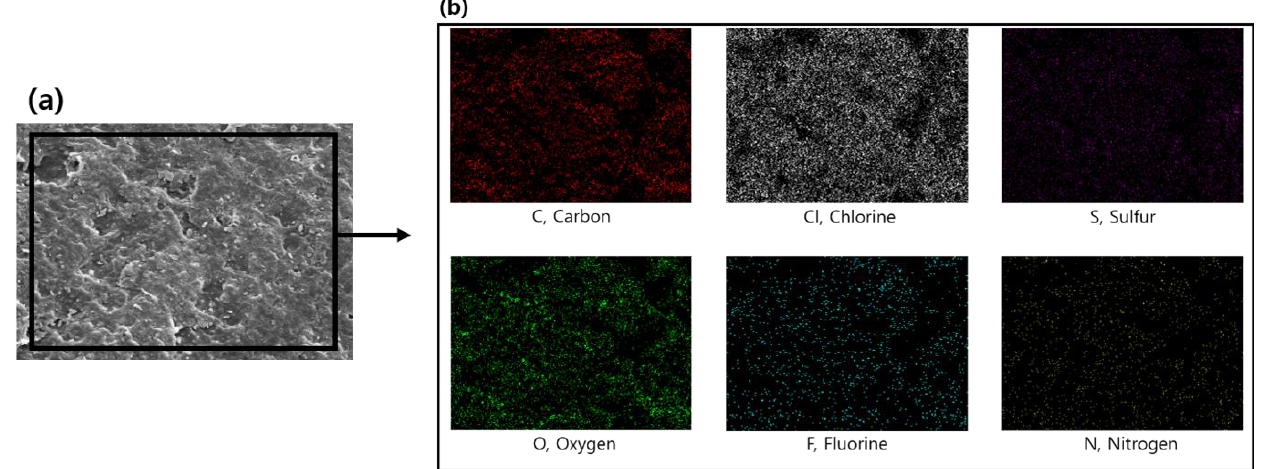
Figure 12. SEM-EDS investigation on the insulation of a 40 year accelerated aged cable at ( a ) 500× magnification and ( b ) its